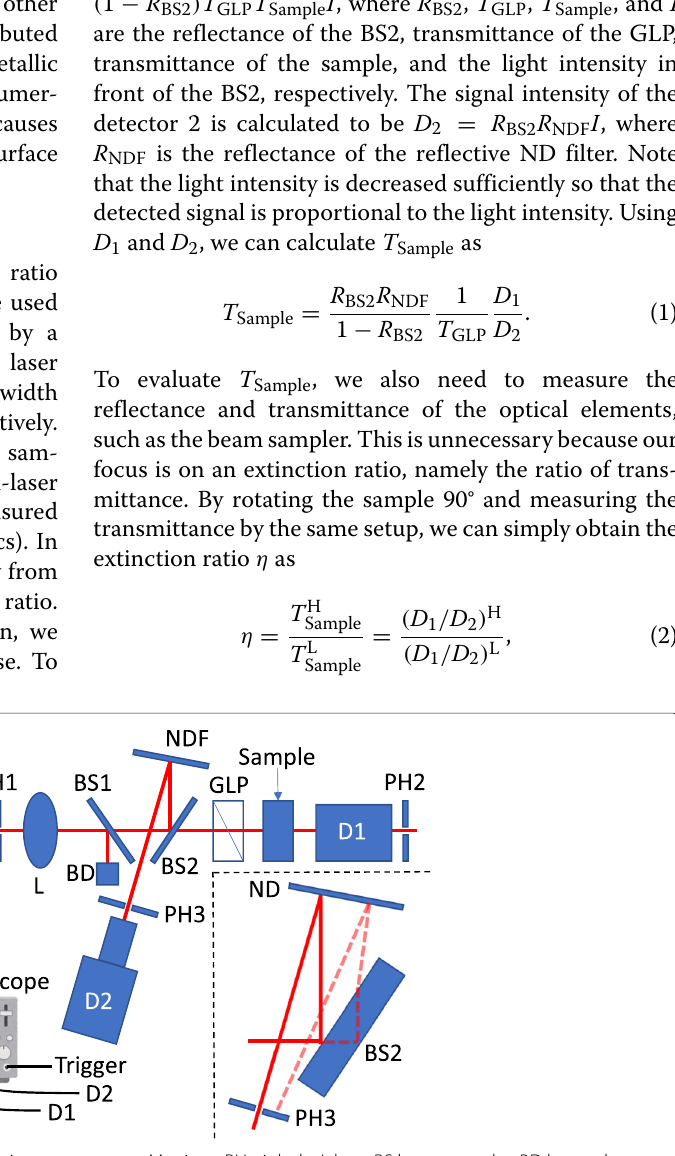
Fig. 1 A schematic of the experimental setup of the extinction ratio measurement. M mirror, PH pinhole, L lens, BS beam sampler, BD beam damper, NDF neutral density filter, GLP Glan-laser prism, D